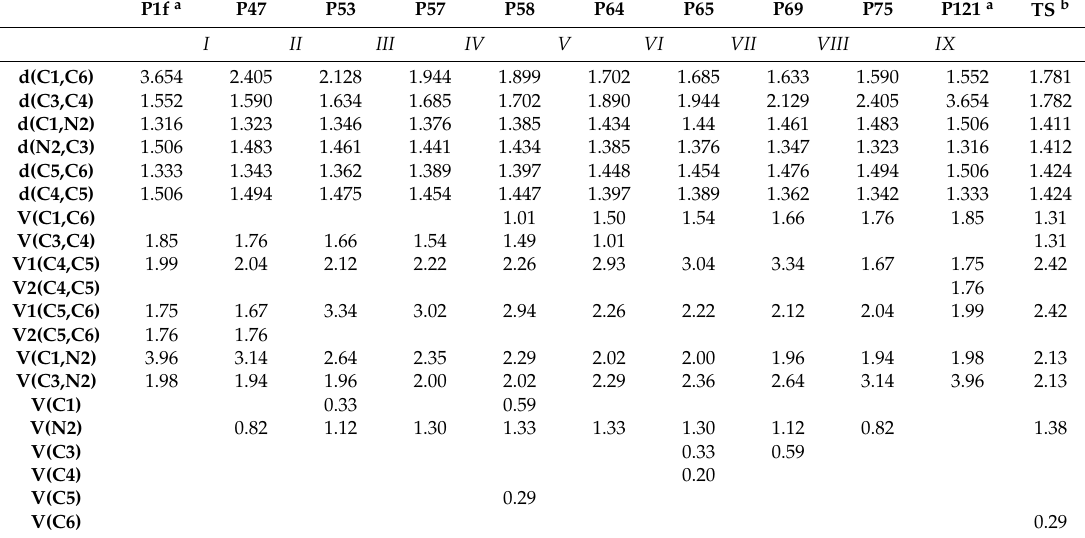
Table 2. Valence basin populations calculated from the ELF of the IRC points, defining the nine SSDs characterizing the molecular 2-aza-Cope rearrangement of 1 . The stationary points 1 and TS1 are also included. Distances are given in